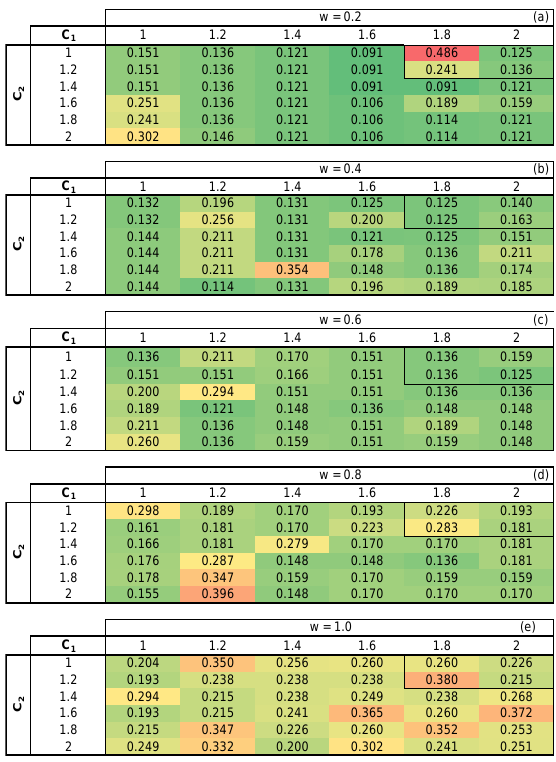
Table 6. Average convergence time in seconds for seven particles.